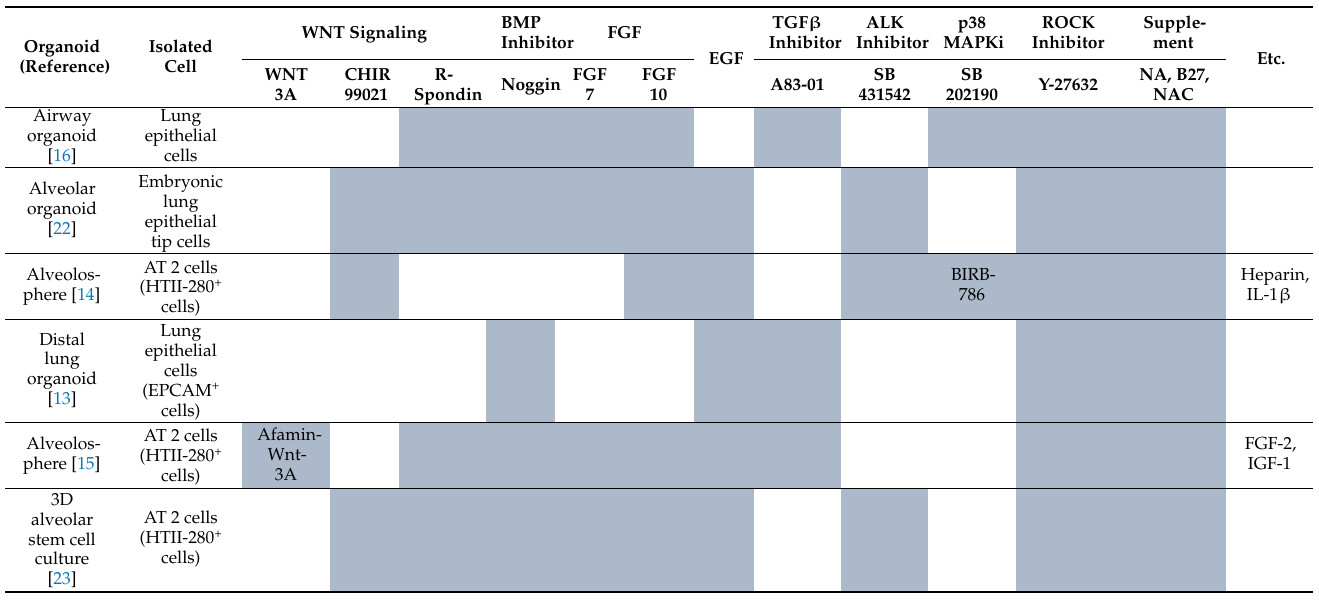
Table 1. Human lung organoid culture